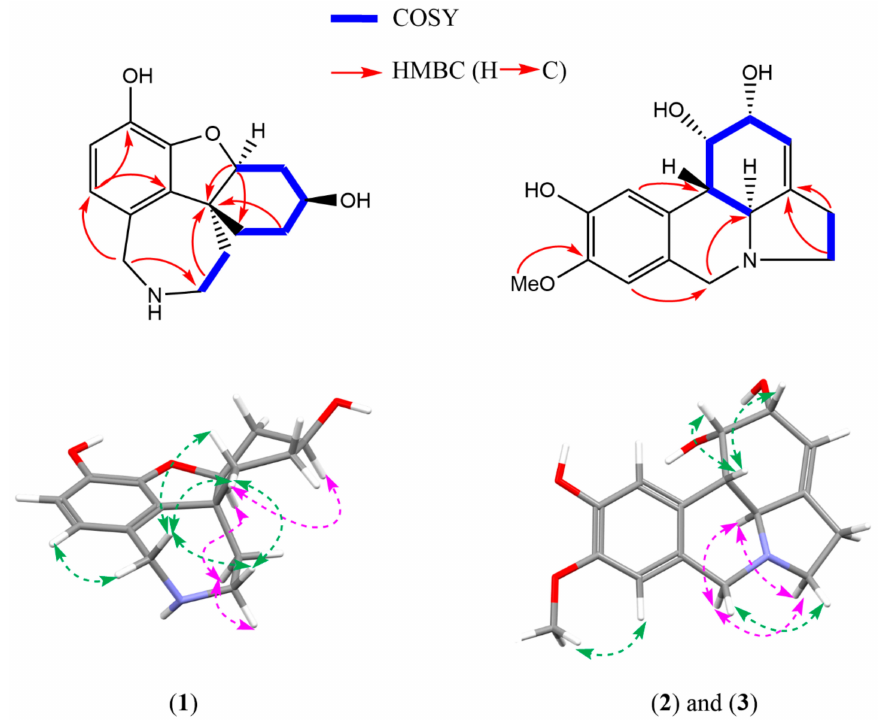
Figure 2. Key HMBC and COSY correlations for compounds 1 – 3 and selected NOESY correlations for compounds 1 – 3 . Green arrows: NOESY correlations above the plane ( β -orientation); Pink arrows: NOESY correlations behind the plane ( α